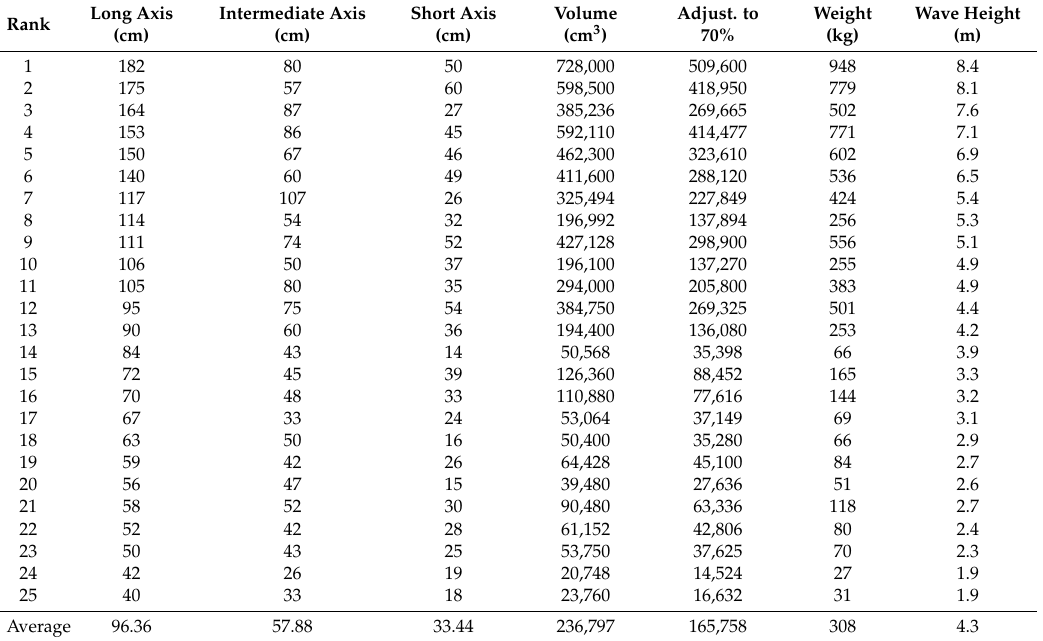
Figure 6. Triangular plot showing the distribution among more cube-shaped, plate-shaped and bar-shaped boulders with sizes and weights recorded in Table 1. Table 1. Quantification of boulder size, volume and estimated weight from the chaotic storm deposit on the 12-m terrace at Arroyo Blanco, Isla del Carmen. The laboratory result for density at 1.86 gm/cm 3 is applied uniformly to all samples in this table. Calculation of wave height is based on results using the formula given by Nott [17].